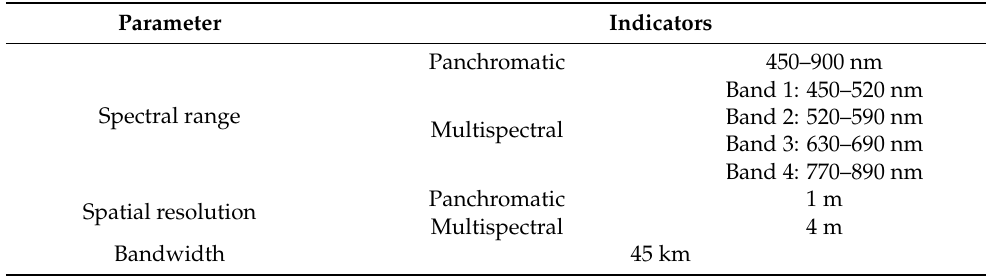
Table 1. GF-2 satellite payload technical